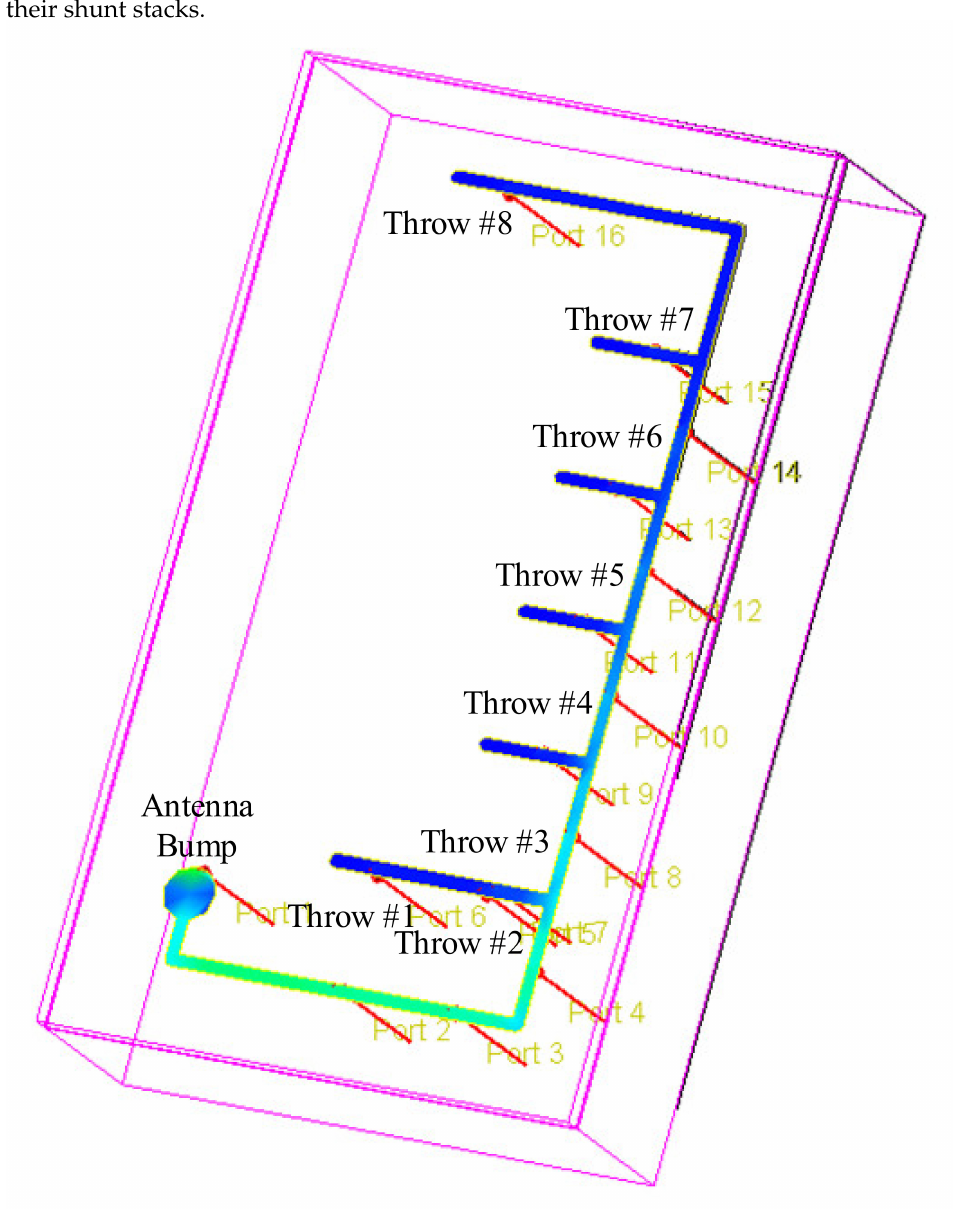
Figure 5. Electromagnetic analysis over the proposed branched antenna paths. To provide a low IL, the width of the transistors, the gate and body resistors, and the level of the bias voltage are the dominant parameters in the design of the switch arm. Meanwhile, due to the compactness of the design, the area occupation is a limiting parameter. Therefore, a 2.3 mm width and 200 k Ω gate and body resistors formed a switch cell. The role of the drain–source resistor is to keep drain–source voltages close to each other. Through a further increase in the width of the transistors, parasitic capacitance increases, and this will affect both the power handling and isolation parameters. A good isolation means that, when an antenna’s RF signal is connected to a throw, other throws be well isolated. By having a larger width, the parasitics of the series stacks increase, which results in greater signal coupling to the throws which are in the